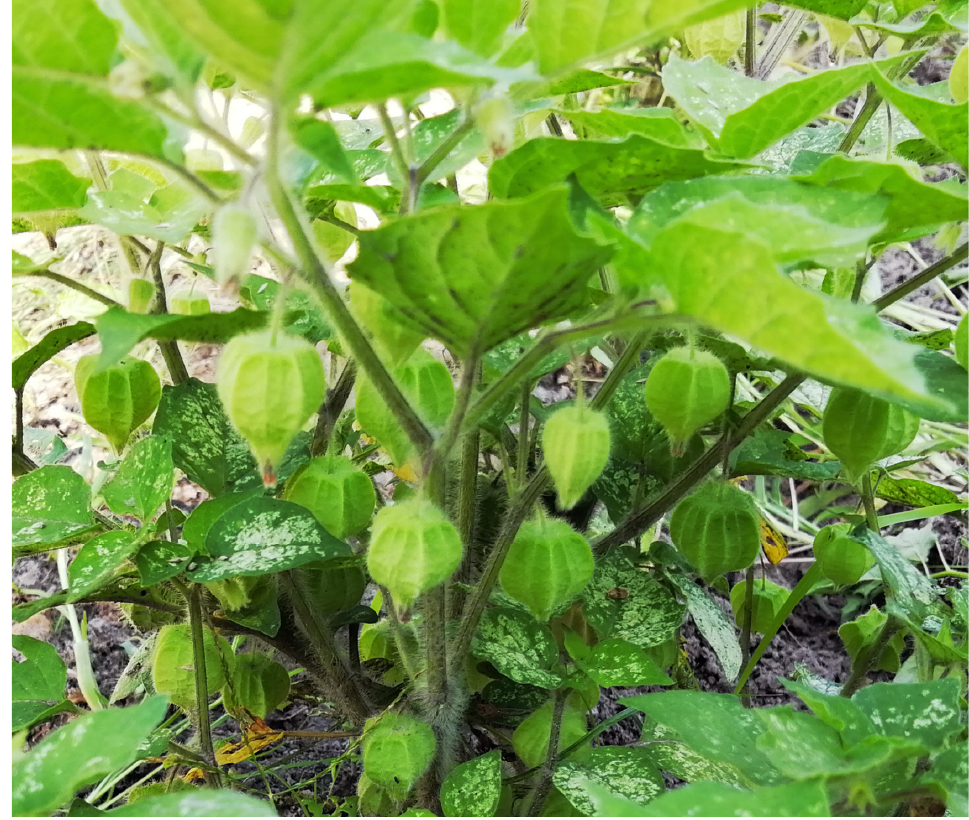
Figure 1. Plant morphology of P. angulata var. villosa in natural habitats.